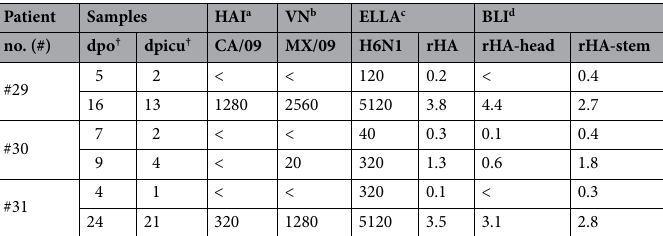
Table 2. A(H1N1)pdm09 virus-infected critically ill patient antibody responses. We completed 3 independent HAI and VN assays. BLI and ELLA assays were performed in duplicate. *Fatal patients in bold; <, titers below 20 in HAI assays and VN assays or ABA < 0.1 nm in BLI assays. † dpo, days post-symptom onset; † dpicu, days post ICU admission; ‡ Anti-NA titers ≥ 5120; NT, not tested. a HAI antibody titers detected by HAI assays using wt-CA/09 (Q223) virus. b Neutralizing antibody (VN) titers detected by VN assays with MX/09 (Q223QR mixture) virus. c Anti-NA antibody titers detected by ELLA assays using H6N1 virus possessing wt-CA/09 NA. d Anti-HA ABA detected by BLI assays using rHA and rHA-head from wt-CA/09, and rHA-stem from A/